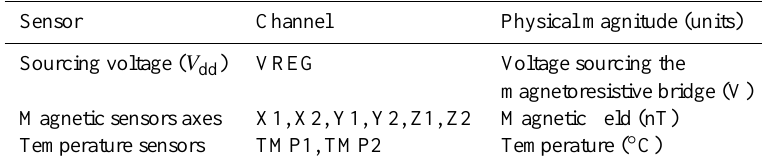
Table 4. Calibration of fluxgate magnetometers. Parameter Specified FG-100 FG-500 Orthogonality error ( ◦ ) ± 0.1 ◦ Offset error in zero field (nT) F. S. Scaling error Frequency